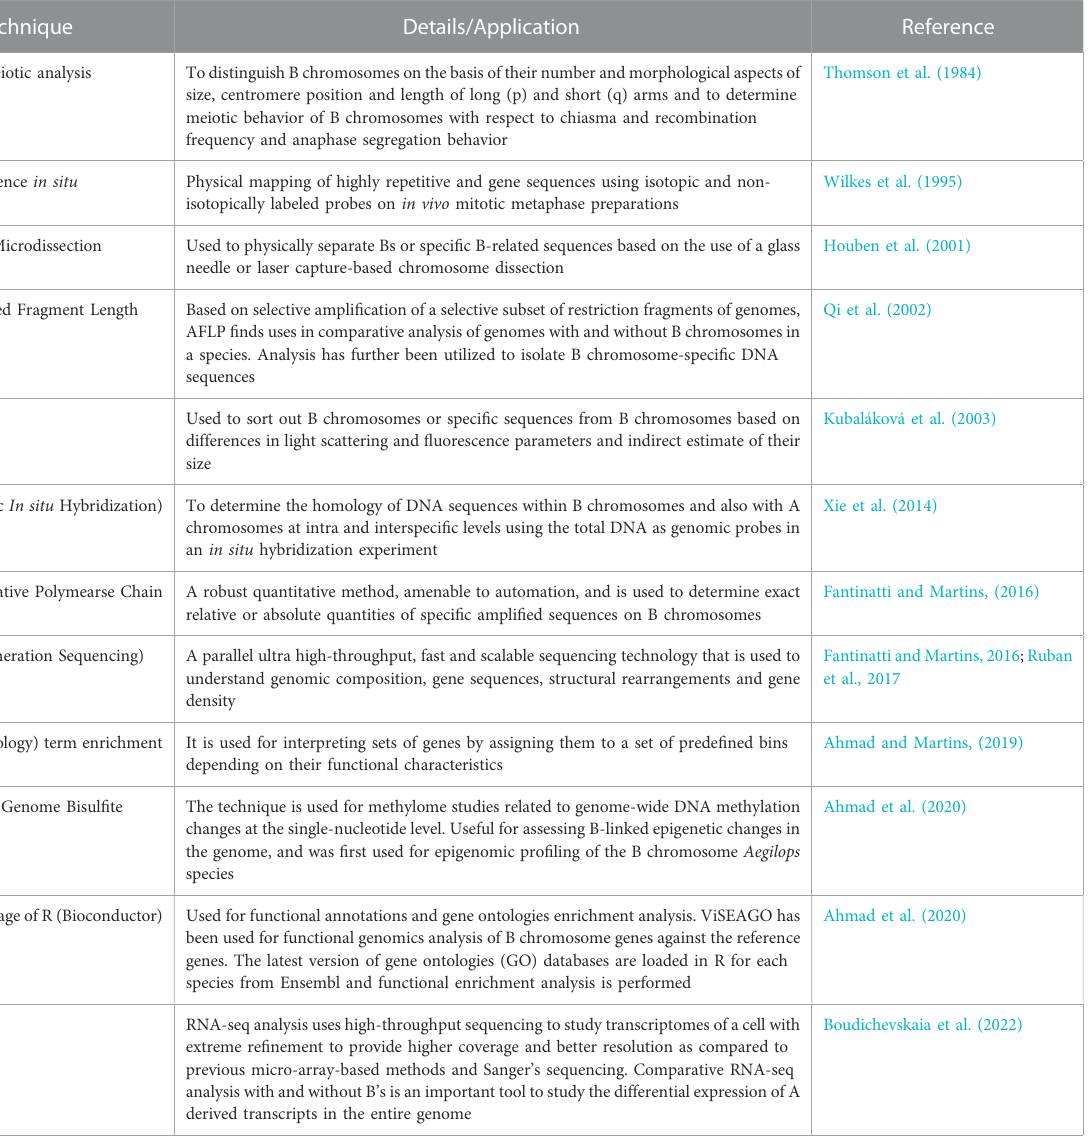
TABLE 1 Techniques used in the studies related to B chromosome